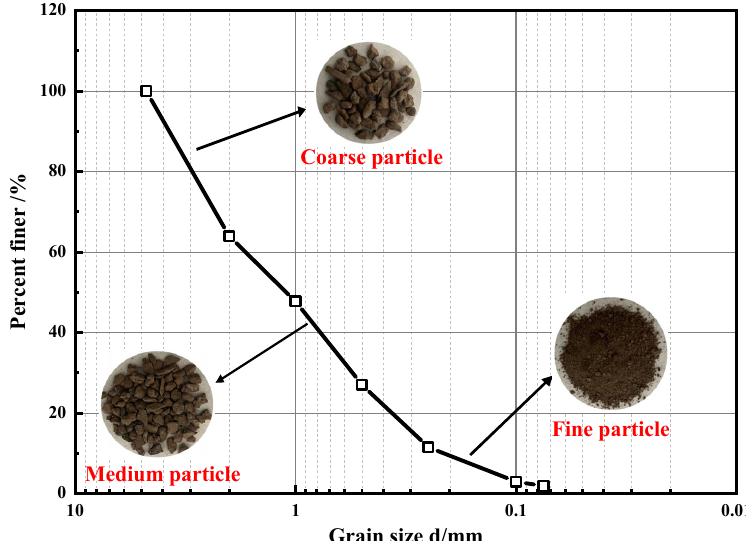
Figure 2. Particle grading curve. Table 1. Physical performance indexes of RA. Table 2. Performance indexes of WPU solution.